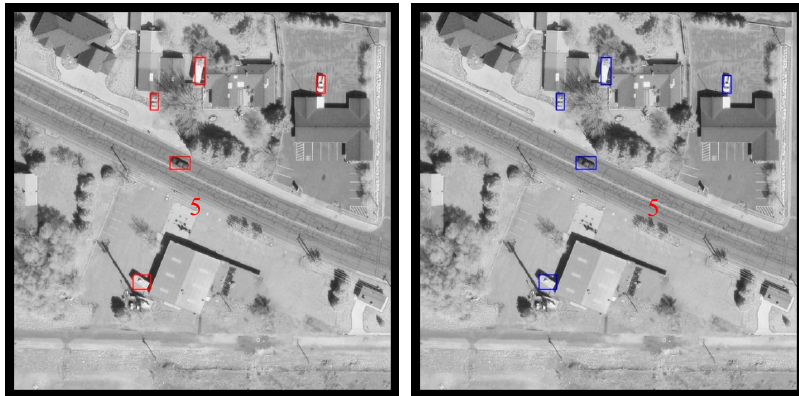
Figure 7. Detection samples from framework1.1 The left column contains the ground truth. The right column contains the results generated by framework1.1.